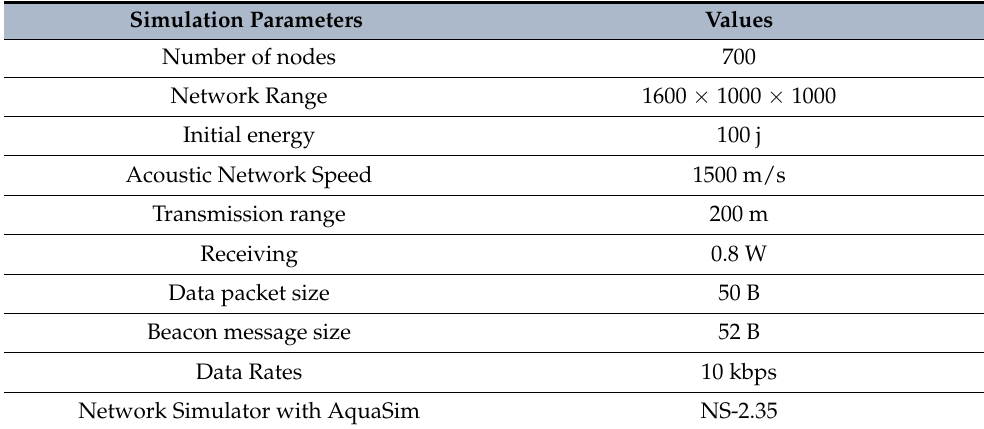
Table 2. Simulation settings and their